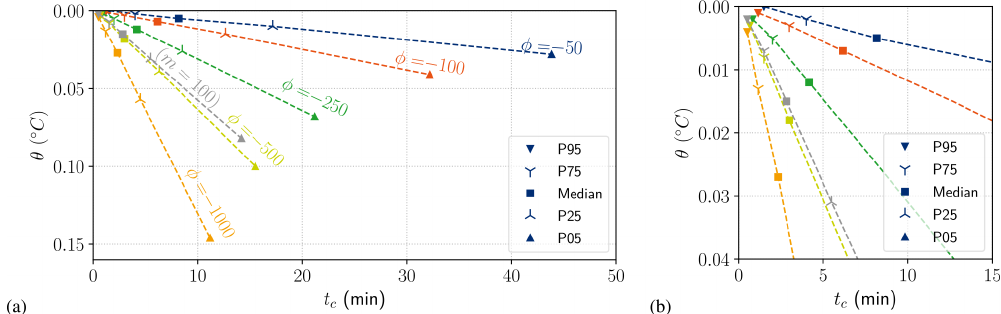
Figure 10. Maximum supercooling point scatter computed from median and 5th, 25th, 75th and 95th percentile time series at different cooling rates ( φ = − 50, − 100, − 250, − 500 and − 1000Wm − 3 ) for case 1 and with φ = − 500Wm − 3 for case 2. Global view (a) and focus on initial time (b) .